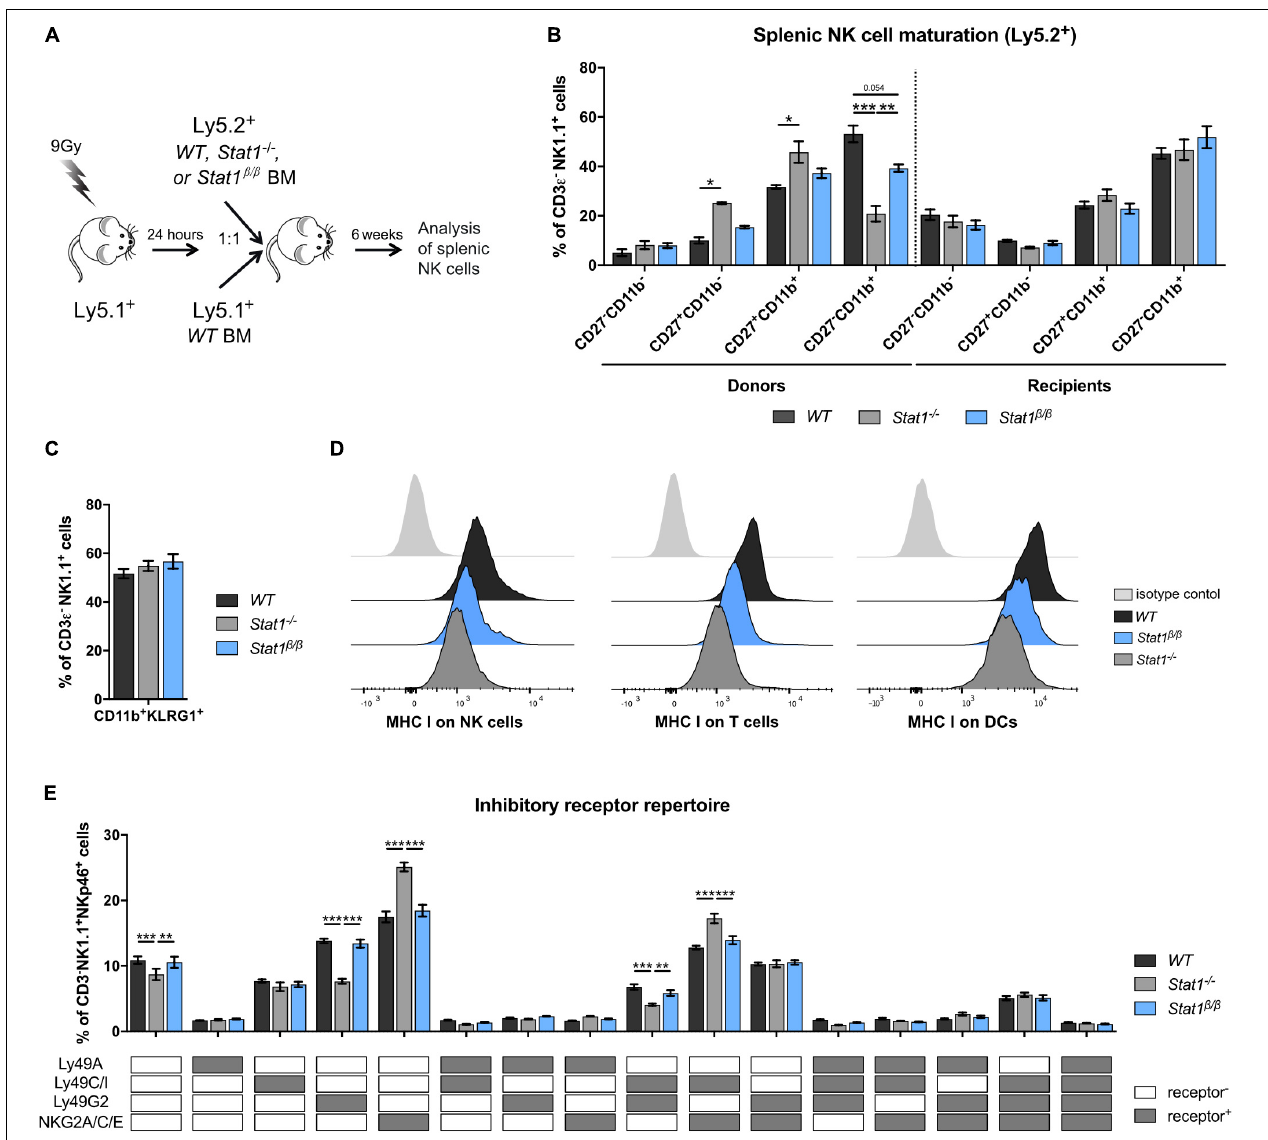
FIGURE 4 | Stat1 β / β NK cells exhibit normal maturation in a WT environment and Stat1 β / β mice have reduced MHC class I surface levels on various splenocyte types but an unchanged NK cell inhibitory receptor repertoire. (A) Scheme illustrating the mixed bone marrow chimera experiments. (B,C) Splenocytes from donor and bone marrow chimeric mice (Ly5.2 + ) were analyzed for the NK cell (CD3 ε − NK1.1 + ) maturation subsets CD27 − CD11b − , CD27 + CD11b − , CD27 + CD11b + , and CD27 − CD11b + (B) and for CD11b + KLRG1 + cells (C) . (D) Surface levels of MHC class I molecules (MHC I) on splenic NK cells (left), T cells (middle) and DCs (right) from WT , Stat1 − / − and Stat1 β / β mice were determined by flow cytometry. Histograms show one representative sample per cell type and genotype and the isotype control, which was comparable for cells from mice of all genotypes. (E) The inhibitory receptor repertoire of splenic NK cells (CD3 ε − NK1.1 + ) from WT , Stat1 − / − , and Stat1 β / β mice was determined by flow cytometry. NK subsets were defined by combinatorial expression of Ly49A, Ly49C/I, Ly49G2, and NKG2A, as determined by flow cytometry, and analyzed by Boolean gating. White and gray boxes indicate whether the population is positive (gray) or negative (white) for the inhibitory receptors listed. Mean percentages ± SEM from three ( n = 5–8) (B,C) and two ( n = 5–6) (E) experiments are shown. * p < 0.05; ** p < 0.01; *** p < 0.001.